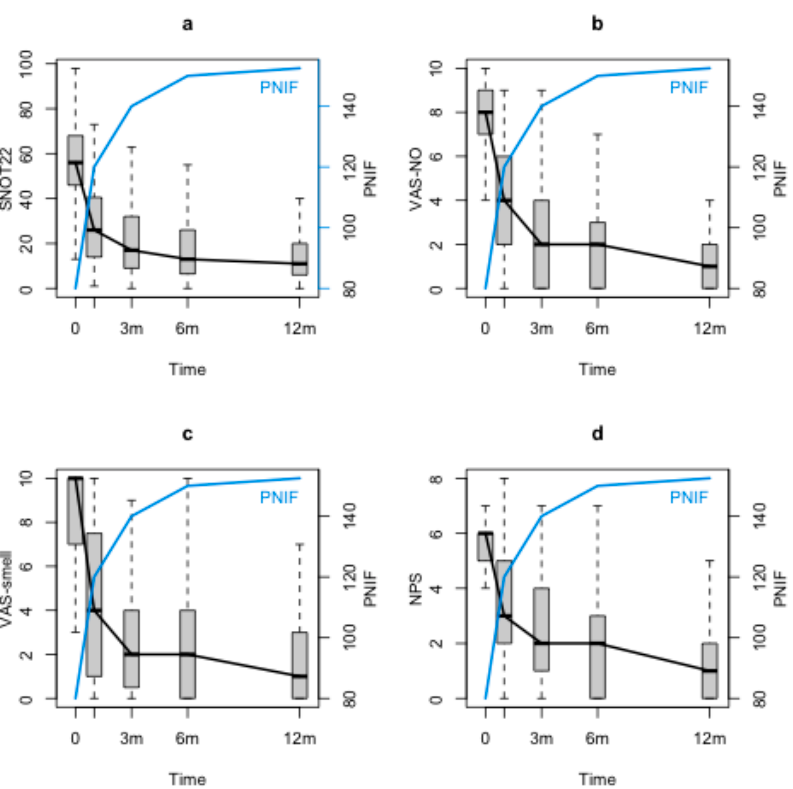
Figure 1. PNIF, SNOT-22, VAS-NO, VAS-smell and NPS changes during the follow-up. PNIF: peak nasal inspiratory flow, SNOT-22: sinonasal outcome test-22; VAS-NO: visual analogue scale for nasal obstruction; VAS-smell: visual analogue scale for smell; NPS: nasal polyps score; m: months. SSIT improved significantly after the baseline (T0) and maintained its improvement through the 12 months follow-up (T1, T2, T3, T4) ( p < 0.0001). At T0, a correlation was observed between SSIT and VAS-smell ( p < 0.001), VAS-NO ( p = 0.02) and NPS ( p = 0.012), but no correlations were observed with SNOT-22. When evaluating SSIT changes during the follow-up through the statistical model, negative significant correlations between SSIT and both nasal symptoms and NPS were found (SSIT and SNOT-22 ( p = 0.0002), Figure 2a; SSIT and VAS-smell ( p < 0.0001), Figure 2b; SSIT and VAS-NO ( p < 0.0001), Figure 2c; SSIT and NPS ( p = 0.03), Figure 2d).